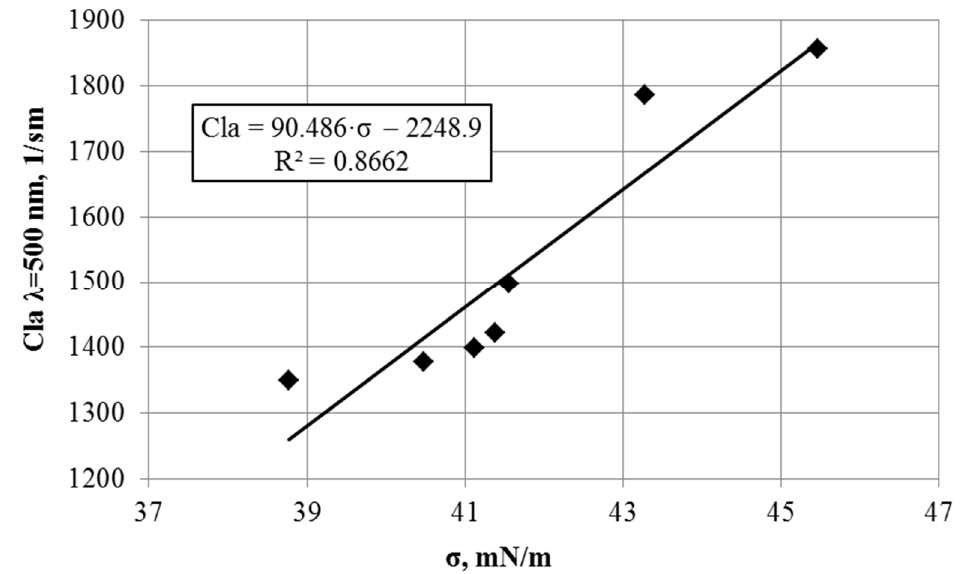
Figure 6. Relationship between coefficient of light absorbance and interfacial tension at the oil–air interface [101].